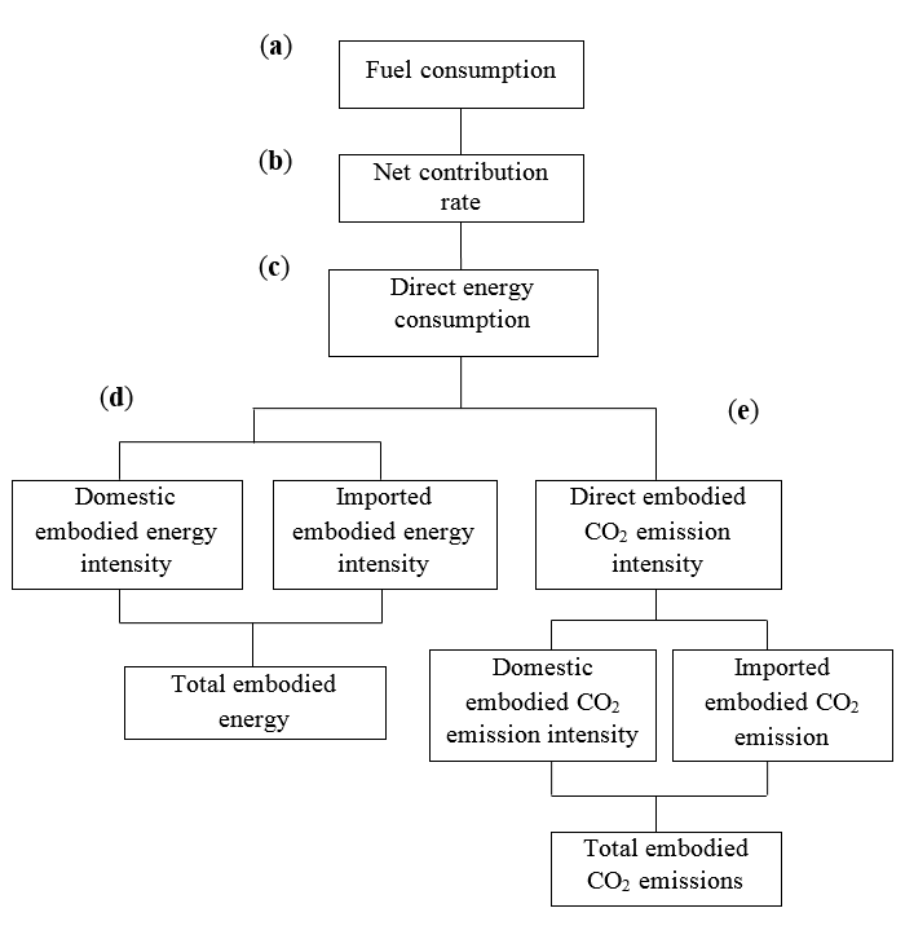
Figure 3. Flow chart of I-O analysis-based method for embodied energy. ( a ) Fuel consumption calculation, ( b ) determination of net contribution rate, ( c ) net calorific value, ( d ) embodied energy calculation and ( e ) embodied CO 2 emission calculation.